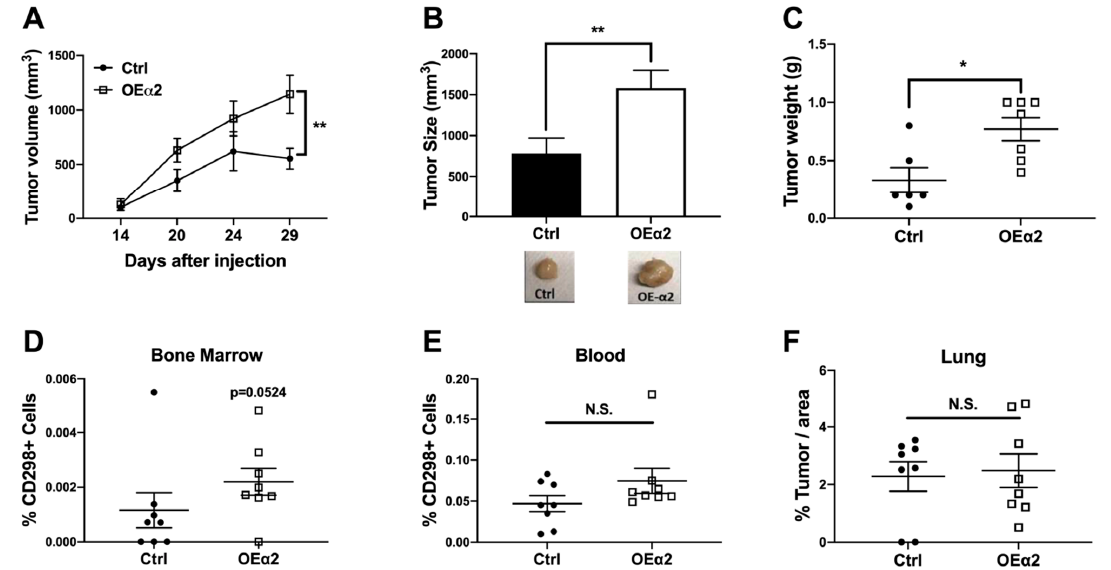
Figure 2. Four–six-week-old athymic nude mice were injected with 5 × 10 5 MDA-Ctrl or MDA-OE α 2 cells into the mammary fat pad. Mice injected with MDA cells overexpressing α 2 had increased tumor growth ( A ), larger tumors at sacrifice ( B ), and increased tumor weight ( C ) compared to mice injected with control MDAs. ( D , E ) Flow cytometry analysis was performed on bone marrow and blood using a novel protocol to detect the presence of human tumor cells using the marker CD298 (ATP1B3). Mice injected with cells overexpressing the integrin α 2 subunit had an increased % CD298 + cells in the bone marrow ( D ), and a trending (n.s.) increase in the blood ( E ) compared to mice injected with control cells. ( F ) Lung metastases were quantified by histological analysis, and no difference was observed between OE α 2 and Ctrl cells. N = 8 per group. Mice were sacrificed 30 days post tumor inoculation. Two-way ANOVA and Mann–Whitney test. * p < 0.05, ** p <